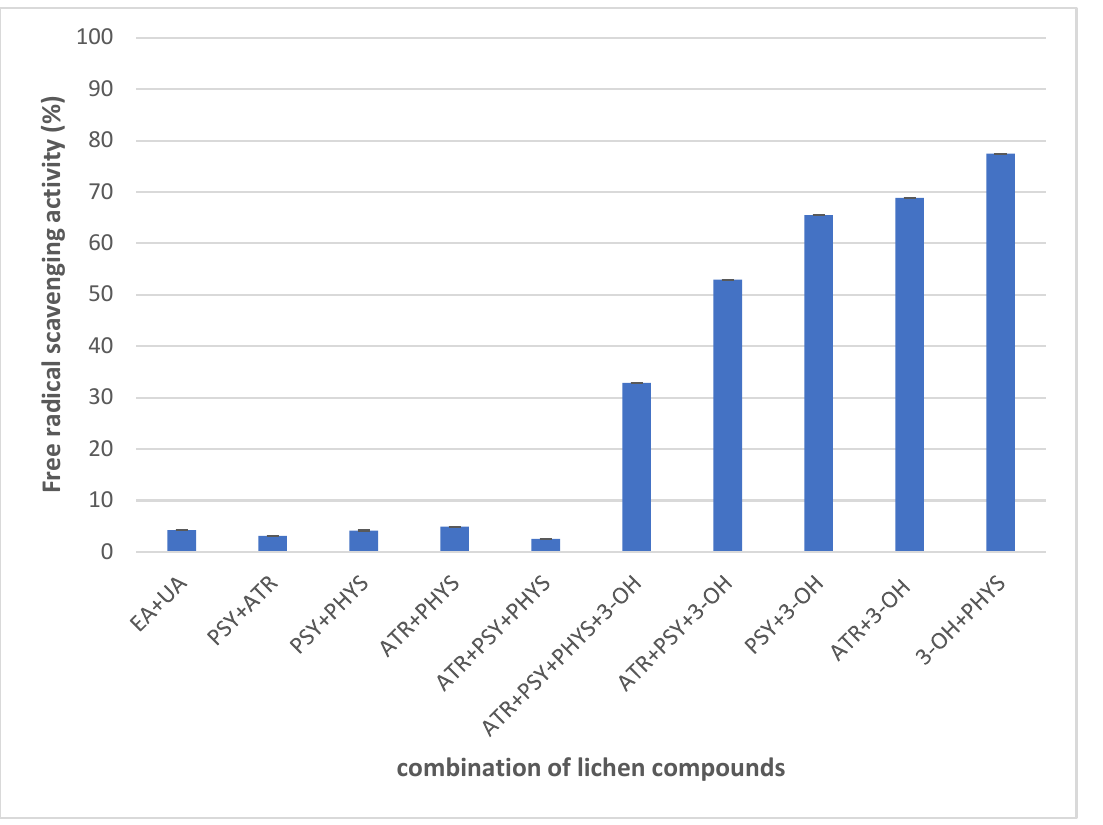
Figure 4. ( A ): Free radical scavenging activity of lichen metabolites and ascorbic acid as reference compound ( n = 3); ( B ): free radical scavenging activity showed by a combination of lichen compounds ( n = 3). Abbreviations mean: EA (evernic acid), UA (usnic acid), PSY (physodic acid), ATR (atranorin), PHYS (physodalic acid), 3-OH (3-hydroxyphysodic acid.